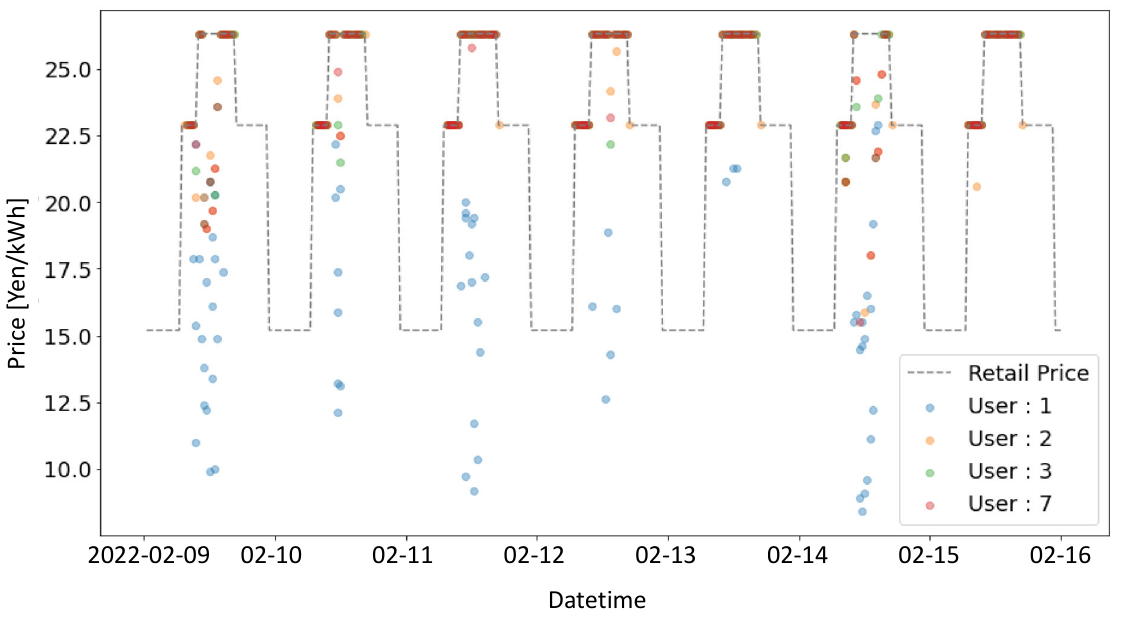
Figure 7. Trends in contract prices for all users in Phase 3 of the experiment.